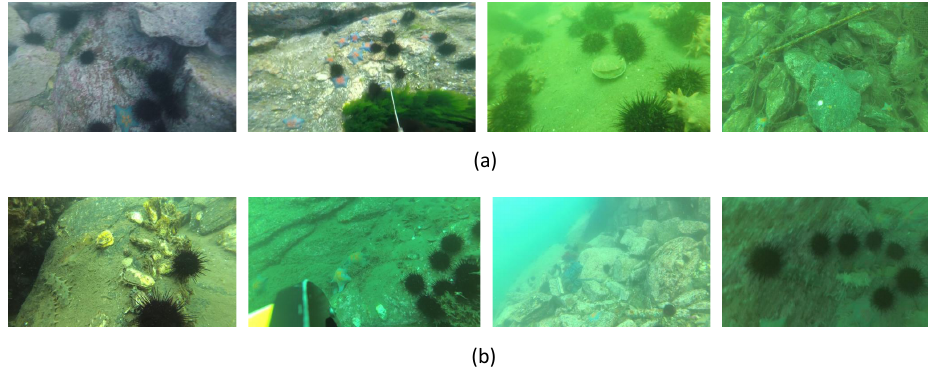
Figure 7. Samples of the URPC2021 and DUO datasets. ( a ) URPC2021 dataset; ( b ) DUO